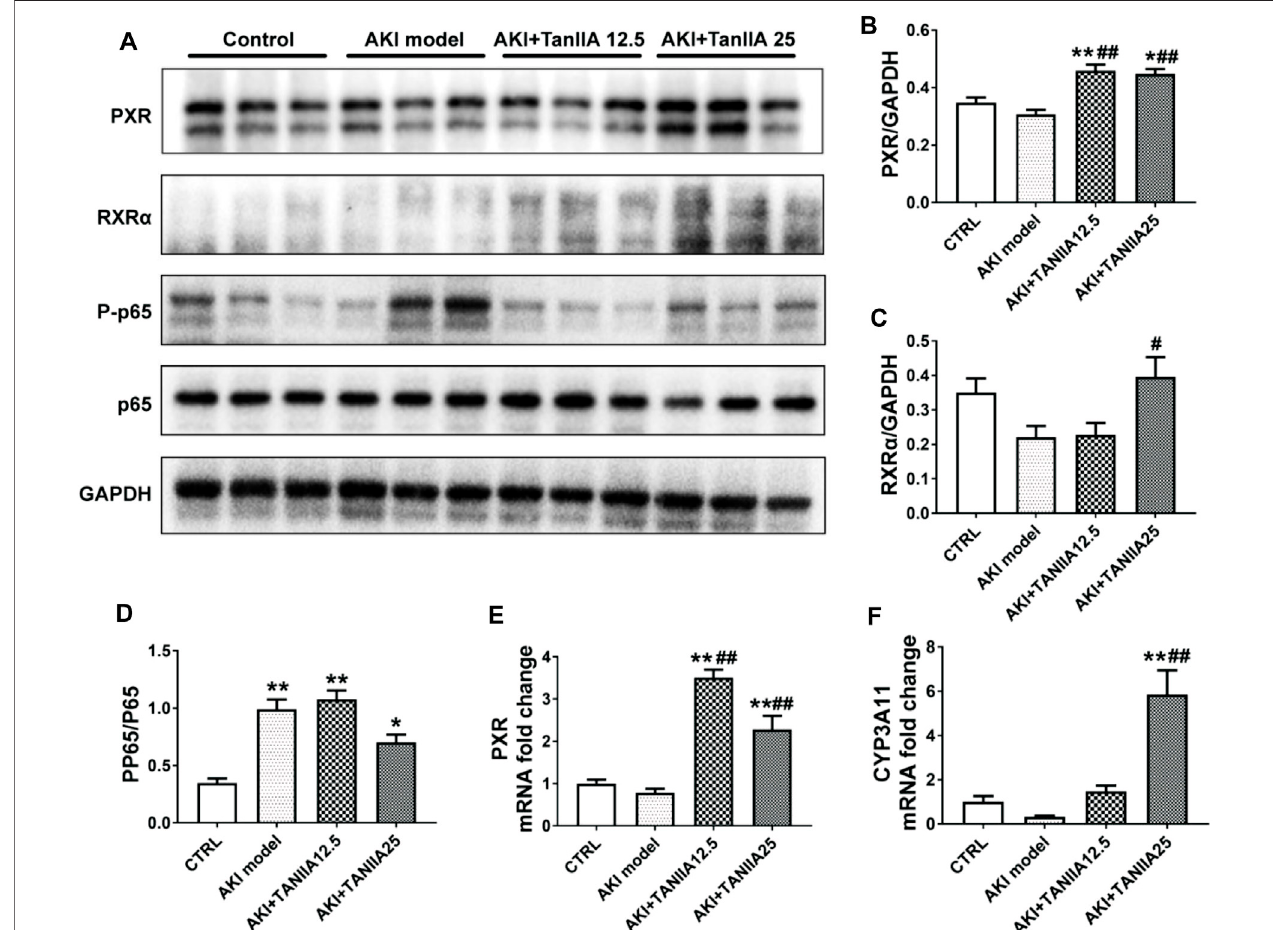
FIGURE5| TanIIAactives mousePXRandinhibitNF- κ Bactivity,and upregulatesPXR-mediated Cyp3a11 expressioninAKImodel. (A – D) Theprotein expression andrelativequantitativedataofPXR,RXR α ,phospho-NF- κ Bp65,andNF- κ Bp65inkidneys; (E,F) mRNAexpressionofPXRand Cyp3a11 inkidneys;datarepresentas mean ± SEM, *p < 0.05, **p < 0.01 compared with the control group ( n = 5). #p < 0.05, ##p < 0.01 compared with the AKI group ( n = 5). Student ’ s t -test was used for paired data. One-way ANOVA followed by Turkey ’ s test for multiple comparisons was used for three or more groups; abbreviations: PP65, phospho-NF- κ B p65; P65, NF- κ B p65; Cyp3a11 , cytochrome P450